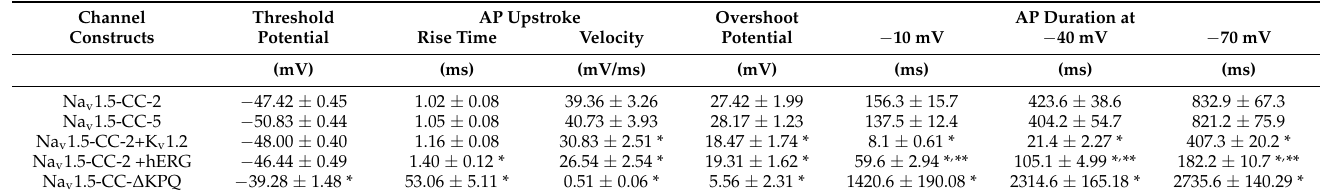
Table 3. Statistics on AP parameters. For current amplitudes, oocyte resting membrane potential, and oocyte membrane resistance, see “Supplementary Materials” (Table S1). Number of measurements were at least 12 using at least 4 batches of oocytes. AP upstroke was characterized by the 25–75% rise time and the voltage alteration within this time period.